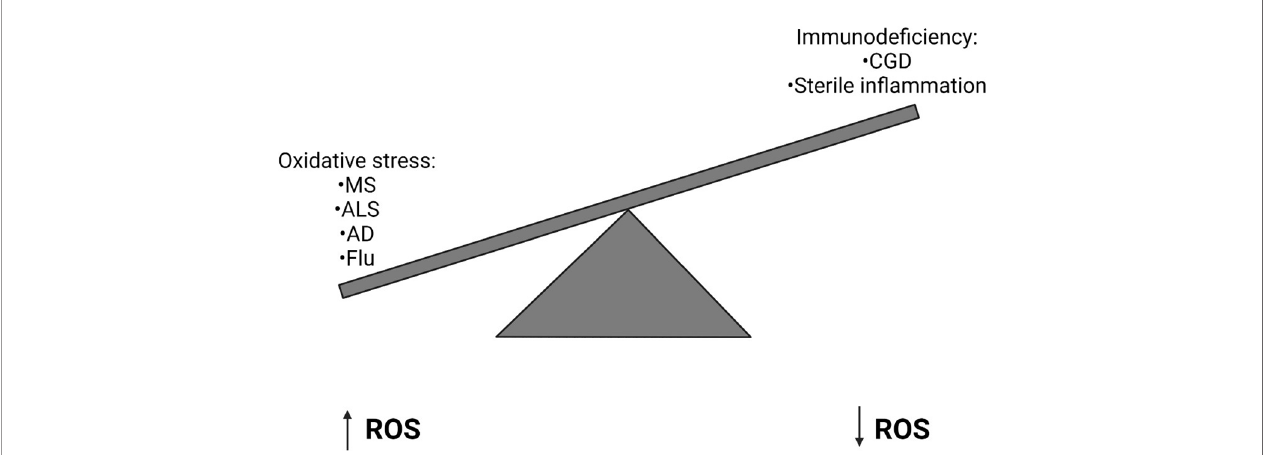
FIGURE 2 | Imbalanced Reactive Oxygen Species generation can have implications for human health. High levels of Reactive Oxygen Species (ROS) can result in oxidative stress, which can lead to a number of diseases including Multiple Sclerosis (MS), Amyotrophic Lateral Sclerosis (ALS), Alzheimer ’ s Disease (AD) and In fl uenza. Alternatively in primary immunode fi ciencies, such as Chronic Granulomatous Disease (CGD), where a genetic defect means ROS are not generated, sterile in fl ammation often